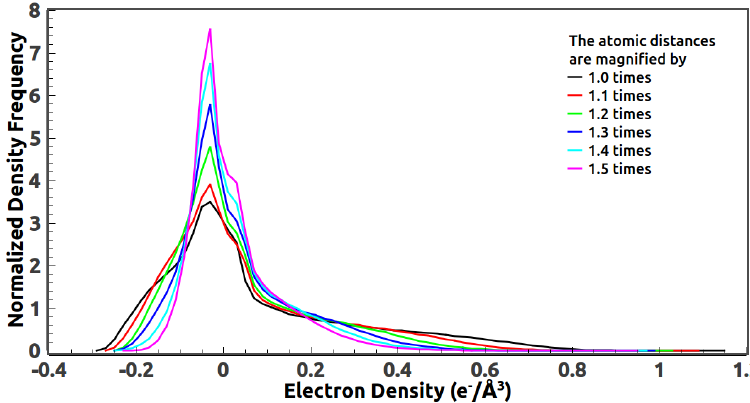
Figure 14. The density histogram of 2JLN at 2 Å is positively skewed (shown as a black line). When the atomic distances are magnified by certain times, the density histograms become less and less positively skewed. The difference between histograms reflects the change of atomic distances. All histograms are calculated from the 2 Å synthetic data of a structure with magnified atomic